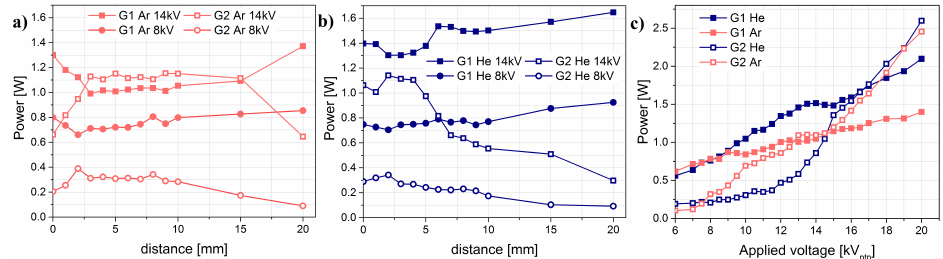
Figure 6. Dissipated power as a function of ( a , b ) distance and ( c ) applied voltage (at d = 5 mm) for helium and argon operation. G1 and G2 describe the measurement position of either grounded ring electrode at the capillary (G1) and ground surface (G2).